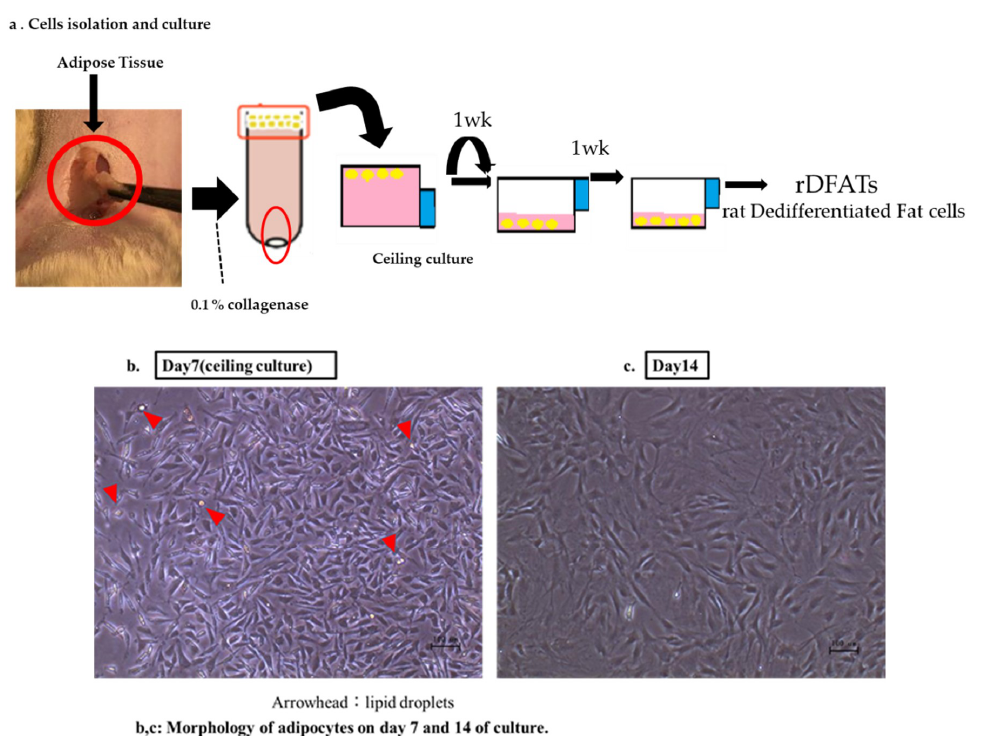
Figure 1. Isolation, dedifferentiation, and culture of mature adipocytes. ( a ) A small piece of adipose tissue was digested with 0.1% collagenase. After centrifugation, unilocular adipocytes were isolated from the floating layer. The isolated cells were cultured in culture flasks filled completely with Dulbecco’s modified Eagle’s medium containing 20% fetal bovine serum for 7 days. During the culture, the cells attached to the upper surface of the flasks and were flattened and converted to fibroblast‐like dedifferentiated fat cells (DFATs). Further, the flasks were inverted, and the DFATs were cultured through conventional methods. ( b ) Morphology of adipocytes on day 7 of the culture. The DFATs derived from a unilocular adipocyte (arrowhead) proliferated and formed a colony (dedifferentiation). ( c ) The DFATs rapidly expanded and reached confluence on day 14 of the culture (proliferation).